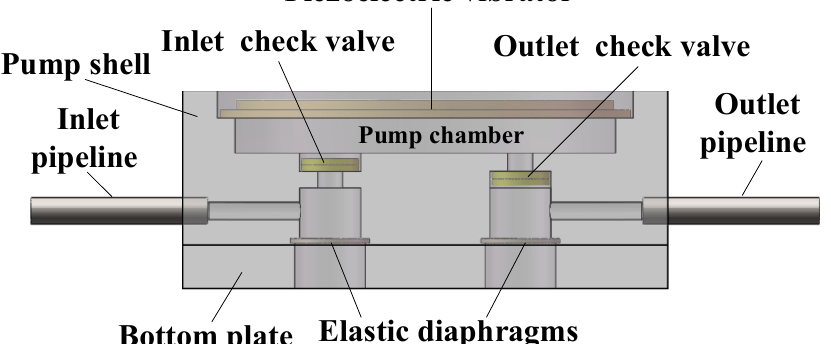
Figure 2. The structure of piezoelectric pump with elastic inlet and outlet. When a piezoelectric pump is working, the liquid in the pump chamber and pipelines is driven by the piezoelectric vibrator to produce high-frequency vibration. According to the working characteristics of the piezoelectric pump, the vibration of the liquid in pipelines and pump chamber can be approximated as sinusoidal vibration. Due to the role of the check valve, the liquid in the pipelines only vibrates in one direction. The elastic cavity is similar to the vibration bu ff er in the mechanical vibration system. The elastic cavity cuts o ff the rigid connection between the liquid in the pump chamber and the liquid in the pipelines. As a result, the velocity fluctuations of the liquid in the pipelines are suppressed. Vibration speed comparison curves of liquid in the pipelines of the traditional piezoelectric pump and the piezoelectric pump with elastic inlet and outlet are shown in Figure 3. The elastic cavity smooths the flow velocity of the liquid in the pipelines and reduces the dynamic load of the liquid in the pipelines.